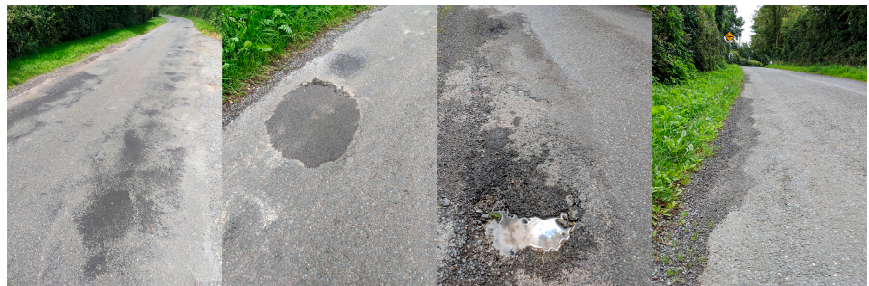
Figure 1. Photo images of several typical road surface defects were taken from the test road segment. From left to right, they show road surface distortion, patching, pothole, and rutting.